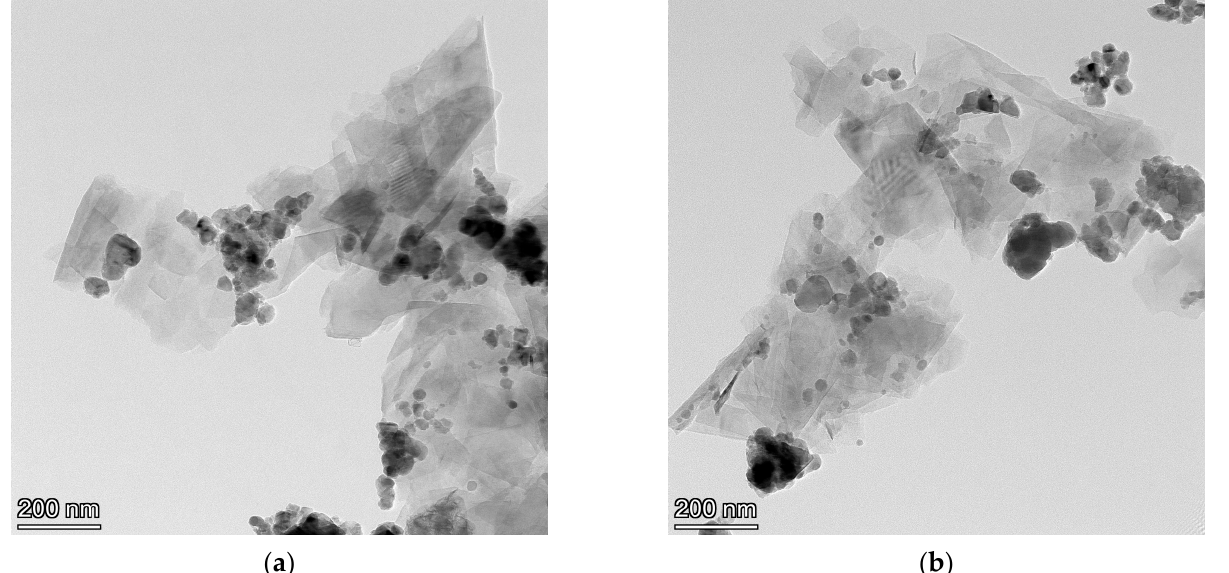
Figure 5. HRTEM topography of four different speeds at ( a ) 160 rpm; ( b ) 280